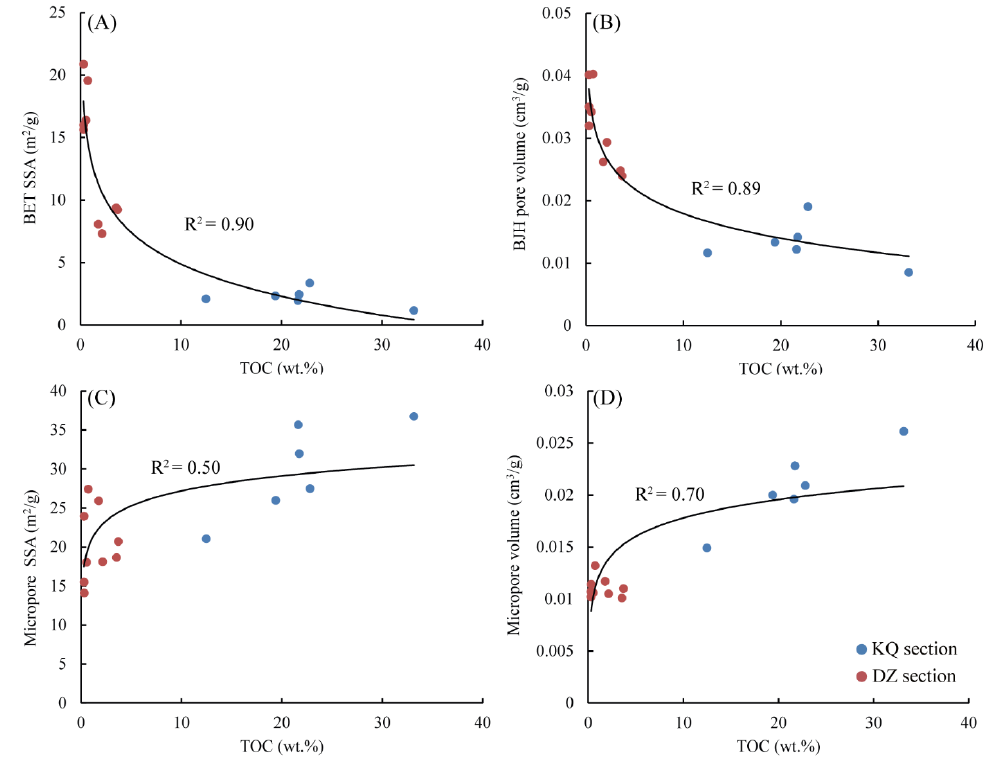
Figure 4. N 2 adsorption isotherms of the studied Chang 7 Member shale samples.